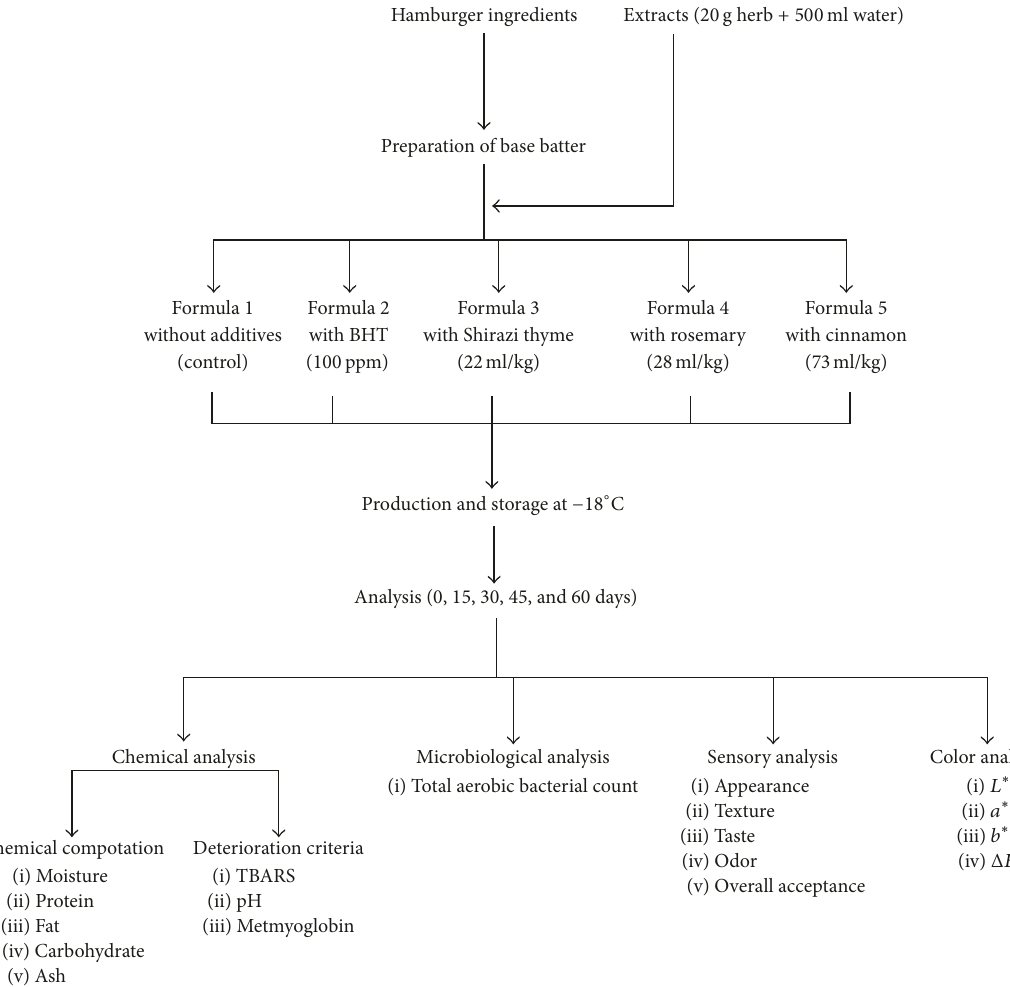
Figure 1: Schematic diagram of experimental